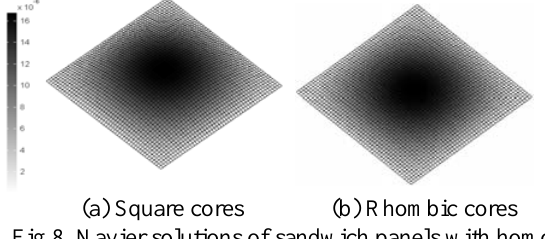
Fig.8. Navier solutions of sandwich panels with homoge- nized